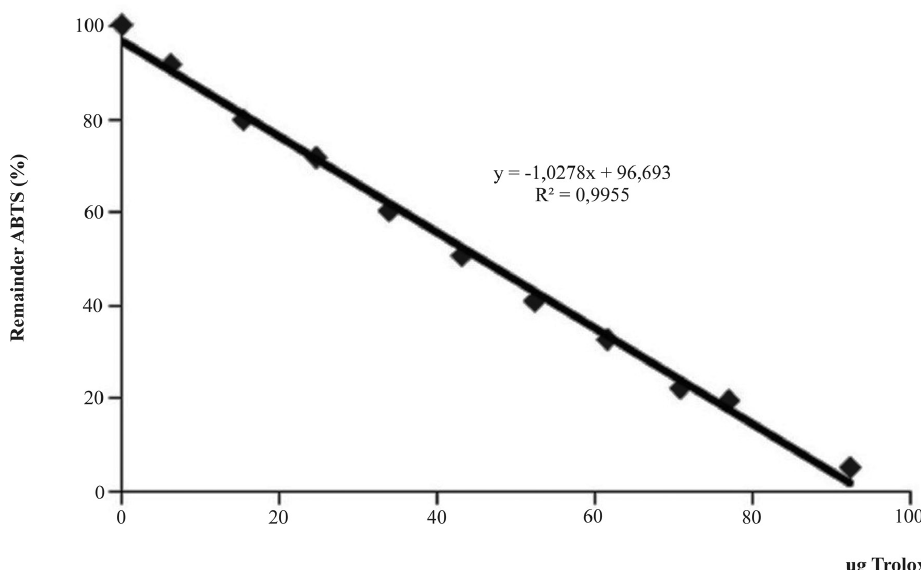
FIGURE 3 – Calibration curve for the ABTS •+ method as generated by measuring the absorbance of the reaction medium at 734 nm. Trolox was used as